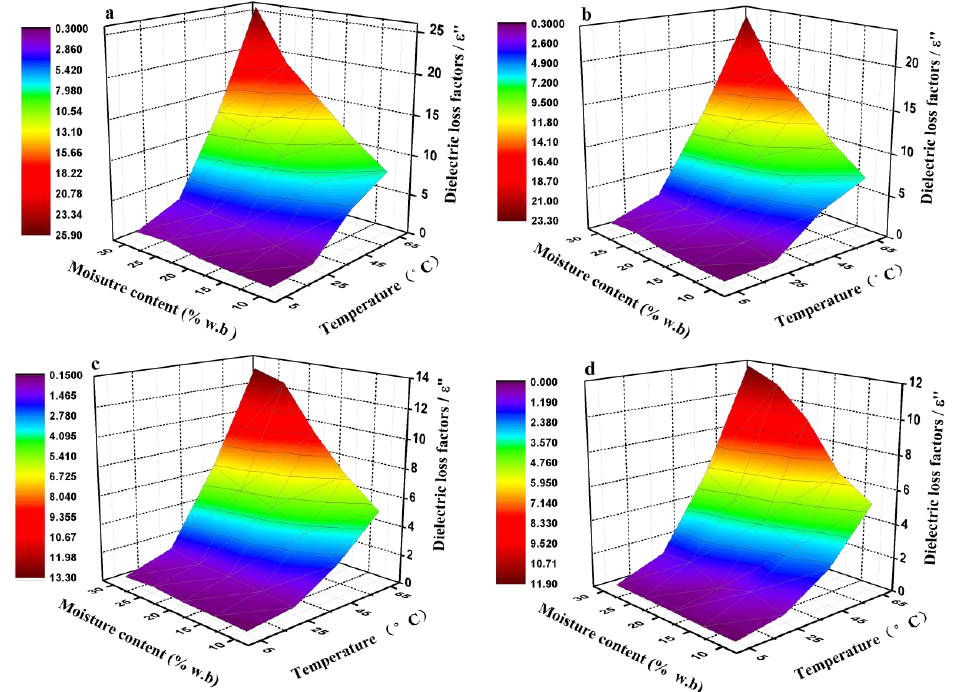
Figure 3. Dielectric loss factors of the pecan kernel samples as functions of the moisture content and temperature at frequencies of ( a ) 27, ( b ) 40, ( c ) 915, and ( d ) 2450 MHz over a moisture content range of 10–30% wb and a temperature range of 5–65 °C.